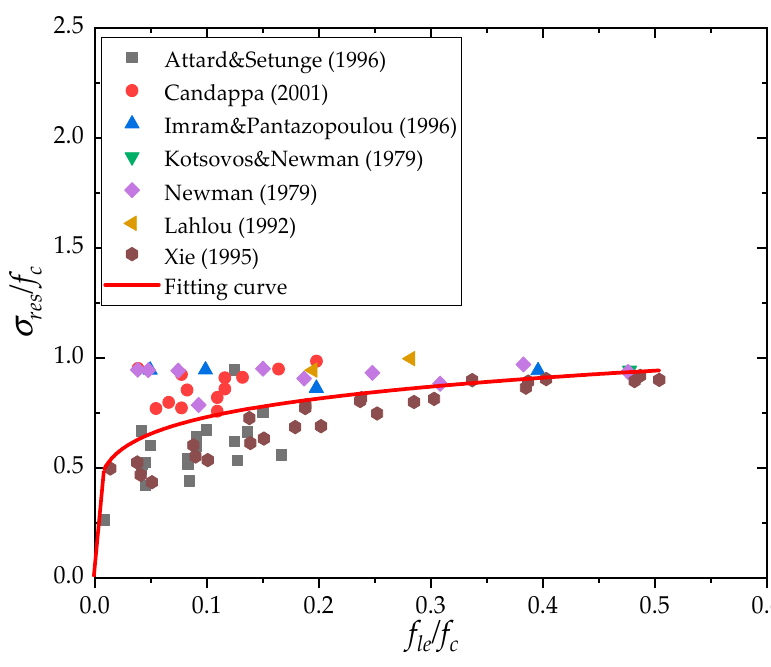
Figure 15. Relationship between σ res / f cc and f le / f c [25,26,28–31,33].